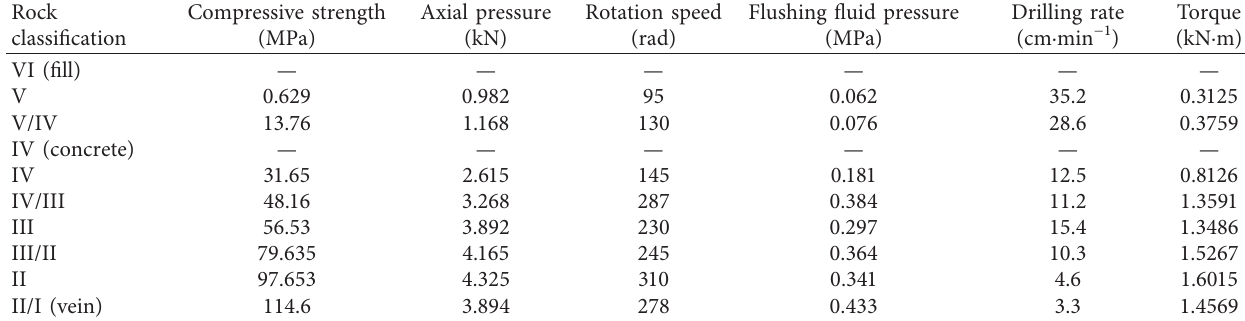
Table 8: Drilling parameters of hole 1.